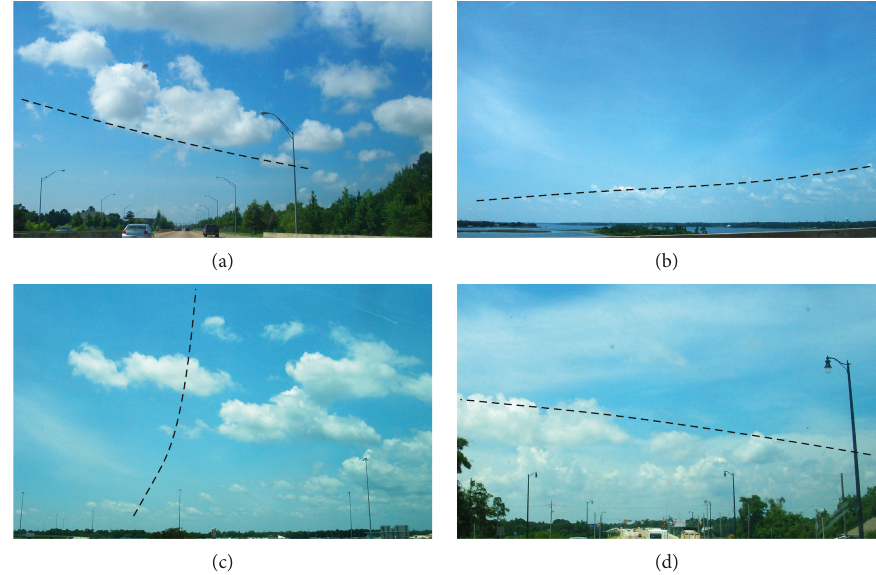
Figure 15: Surface view of cloud development on 10 August 2015. (a) Looking south on US 49 near SBF in Gulfport around 1520 UTC (1020 CDT). (b) View west from Biloxi Back Bay bridge (northbound) around 1808 UTC (1308 CDT). (c) View west of irregular cloud edge near D’Iberville (northbound) around 1811 UTC (1311 CDT). (d) Looking north from 30.4 N (just south of Bayou Bernard) around 1933 UTC (1433 CDT). Dashed line indicates approximate southern boundary to widespread convective